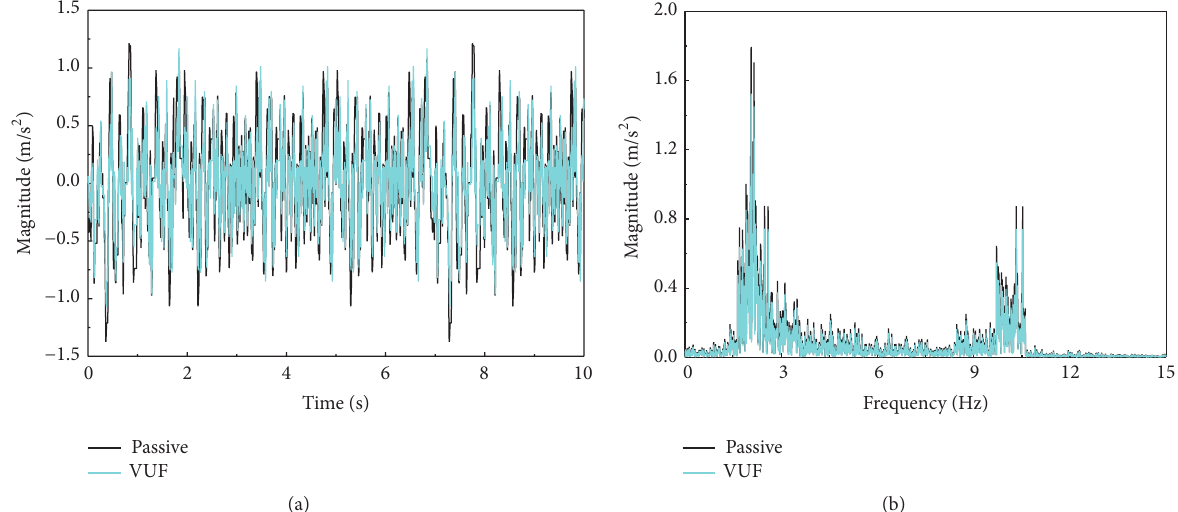
Figure 11: Experimental results of the body acceleration: (a) time domain and (b) frequency